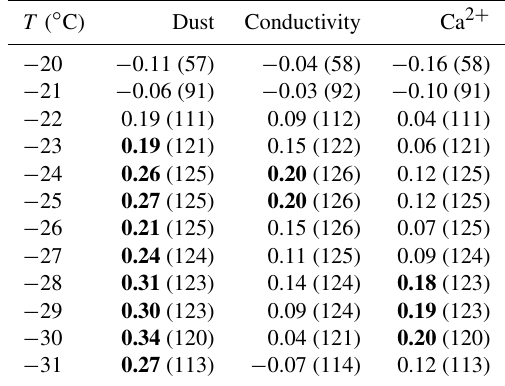
Table 1. Pearson correlation between the INP concentration and se- lected CFA parameters of the complete data set. Bold coefficients indicate a significant correlation ( p< 0.05). The number of samples is given in